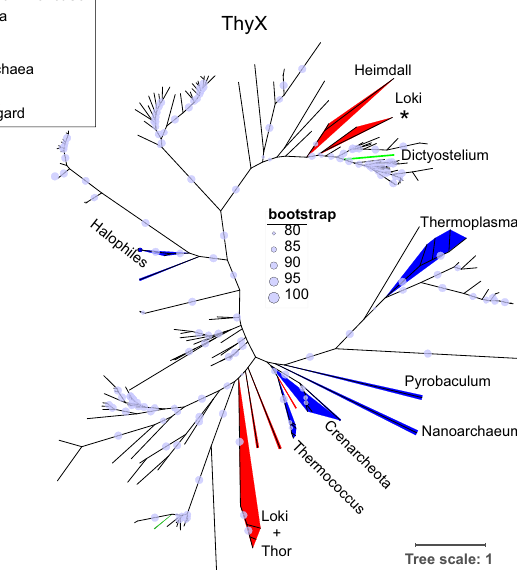
other archaea in blue, bacteria in black, and eukarya in green. The scale bar indi- cates the average number of substitutions per site. Bootstrap values are propor- tionalto the sizeof the circles on the branches. The complete treesare available in the supplementary data.Insets representthesametrees forwhichnodes thathave bootstrap supports lower than 85% have been collapsed. The MCM replicative helicase phylogeny was constructed as control as indicated in the